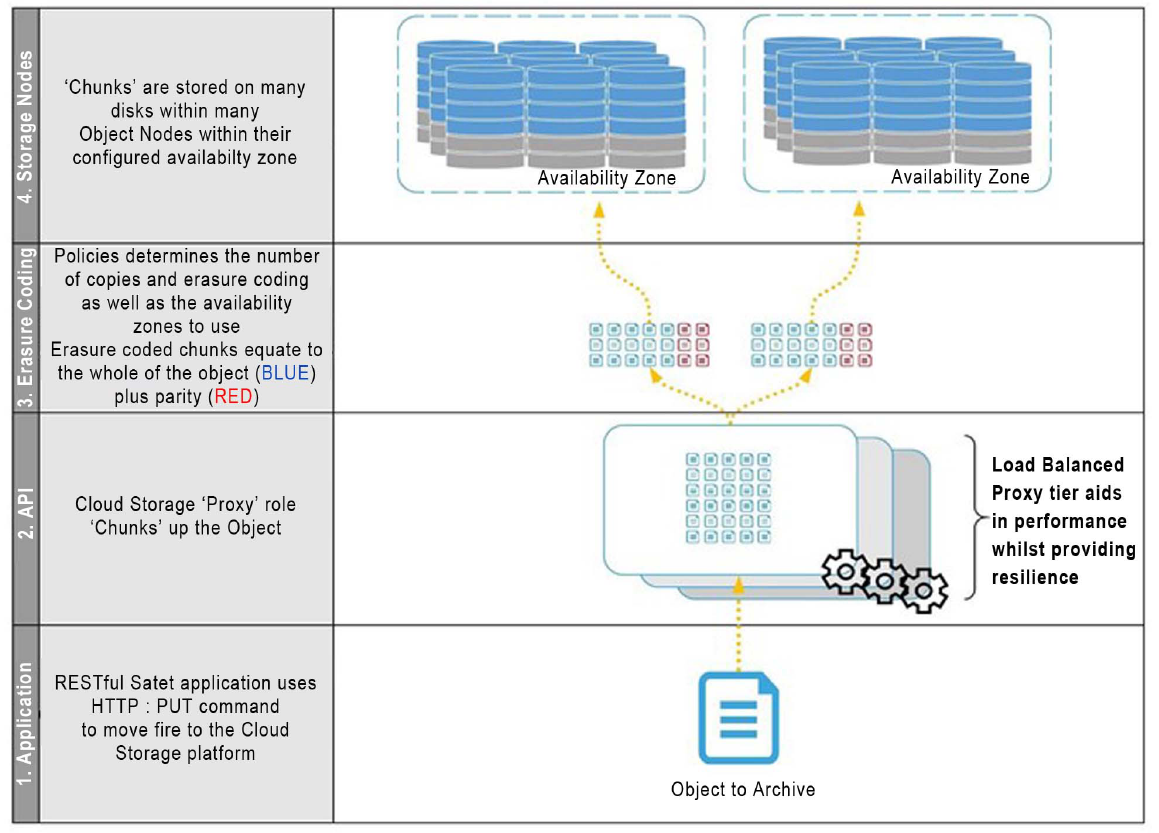
Figure 7. The Archive Storage Service and Object Storage Platform With Native Swift and S3